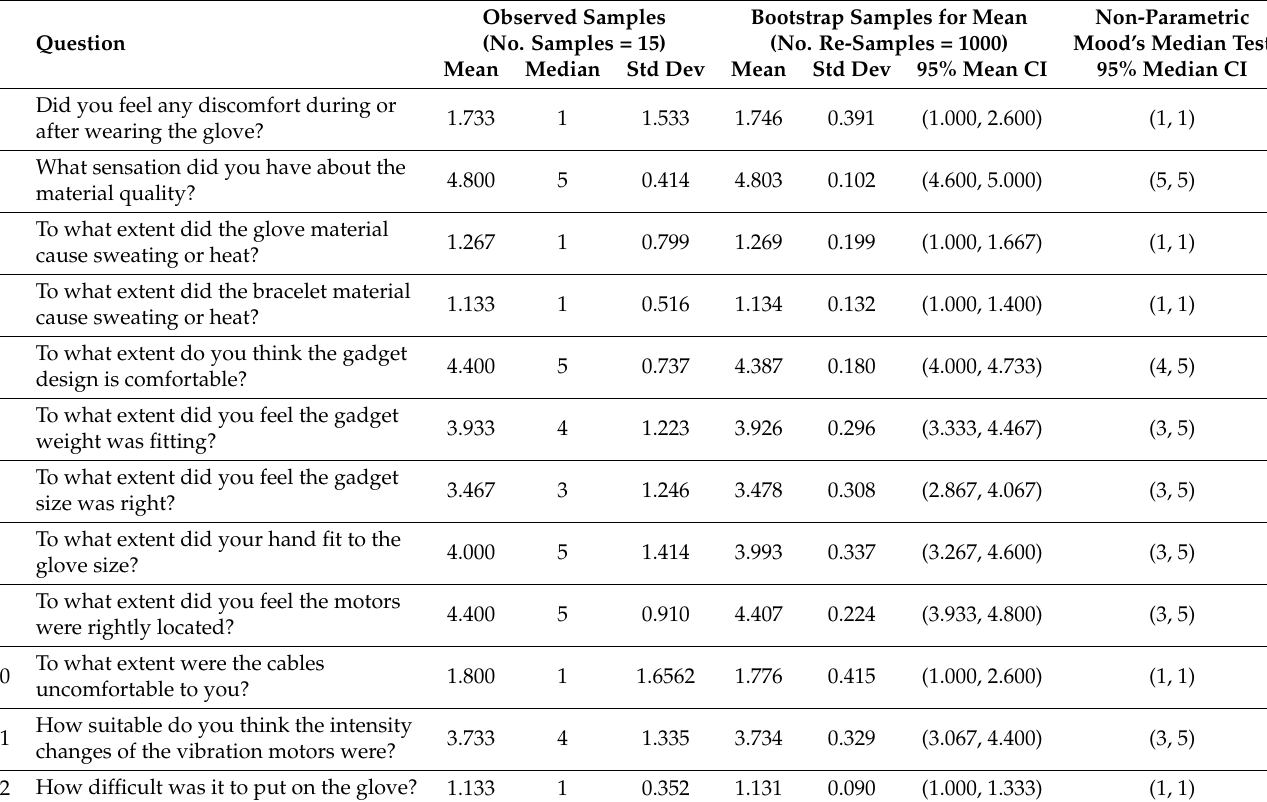
Figure 16. Respondents who enjoy soccer. Table 4. Questions of ergonomics and construction of the glove with statistical